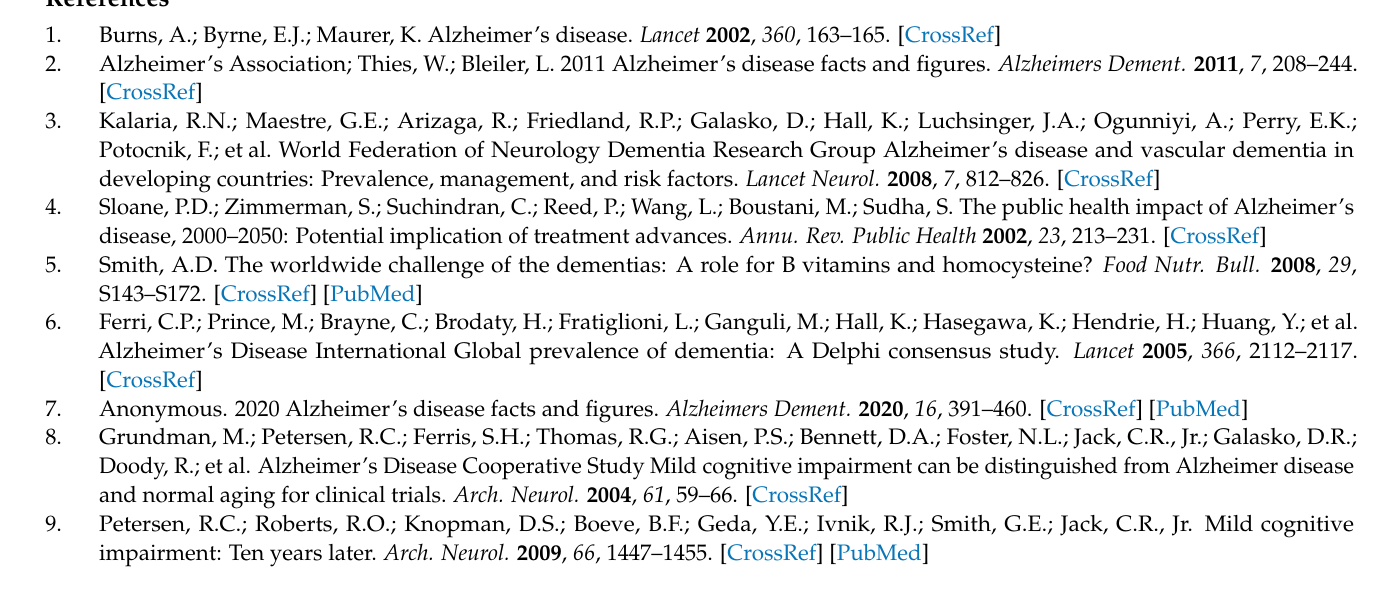
Table S2: Top metabolites different between cognitively normal, MCI and AD based on p -values; Table S3: Top lipid biomarkers for clinical classification of MCI and